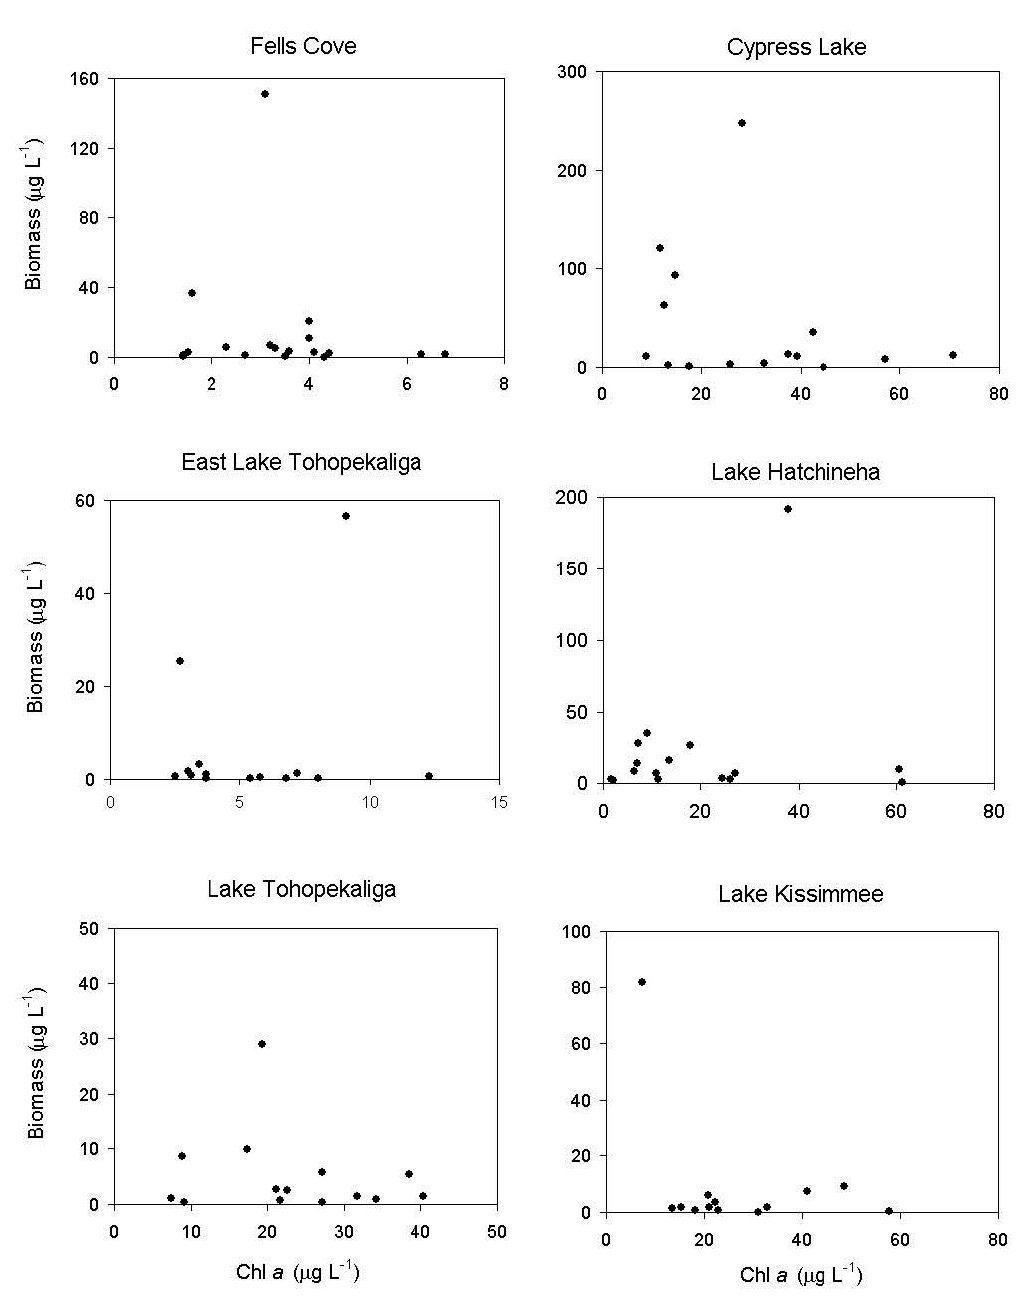
FIGURE 7. Community biomass of macro-zooplankton, plotted as a function of near-shore concentrations of chlorophyll a (Chl α ) on each sampling event, for the six study